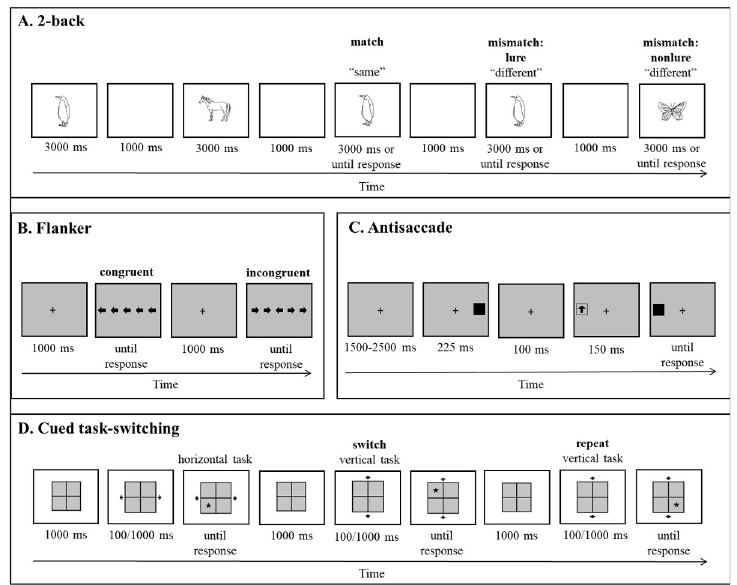
Fig 1. Schematic description of the four executive-function tasks. Phrases appearing above screen figures in boldface represent the conditions in each task. Panels A, B, and D depict series of trials in the 2-back (phrases in quotation marks represent correct responses), Flanker, and cued task-switching tasks, respectively. Panel C depicts a single trial in the antisaccade task. Stimuli are not scaled to size.